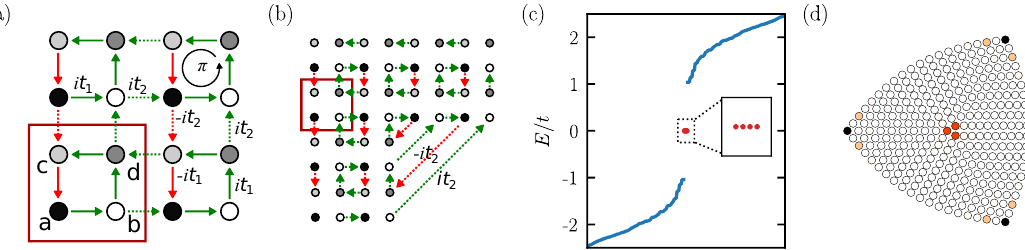
Figure 11: Model of a 2D second-order topological superconductor in class D pro- tected by fourfold rotation symmetry as defined in Eq. (13): (a) depiction of the = t ± δ t . Majoranas hopping along red arrows pick up model Hamiltonian with t 1,2 an additional π phase giving rise to a total magnetic flux of φ per lattice plaquette. 0 The red square denotes the unit cell of the model. (b) Illustration of how to connect = 0), sites across the cuts in the Volterra process for the fully dimerized limit ( t 1 which leads to a π/ 2 disclination at the center of the lattice. Finally, on a lattice with π/ 2 disclination and model parameters δ t = − 0.5 t we show in (c) the spectrum close to E = 0 and in (d) the real-space weights of the zero modes. In (c), the four zero modes in the spectrum are highlighted in